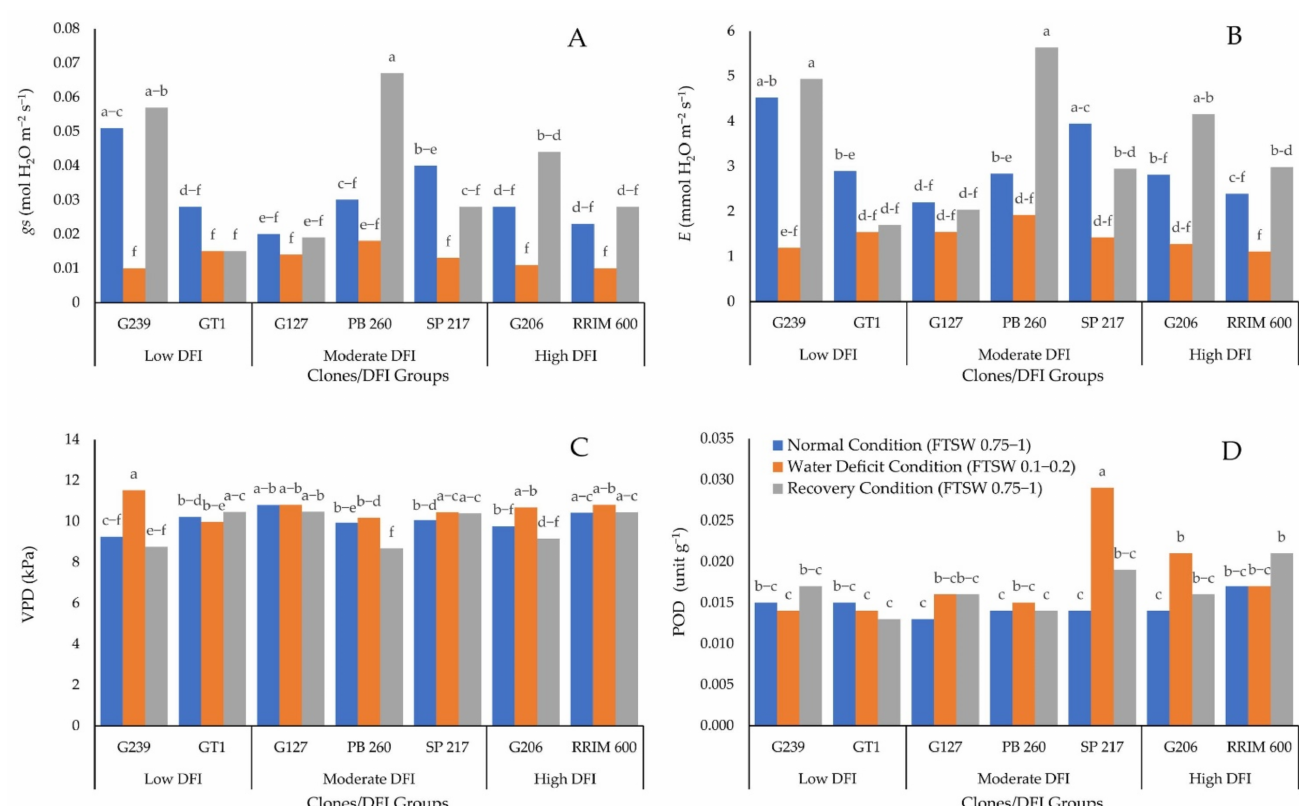
Figure 3. Effect of combination between clone and water deficit level on: ( A ) gs , ( B ) E , ( C ) VPD, and ( D ) POD enzyme activity. The different letters indicate significantly different means determined by the Least Significant Difference test at a 95% confidence